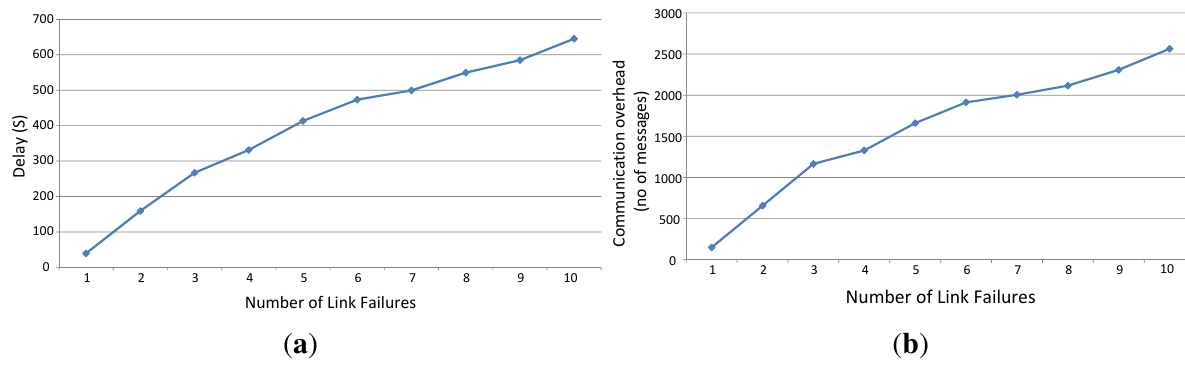
Figure 23. Network maintenance ( a ) delays and ( b )